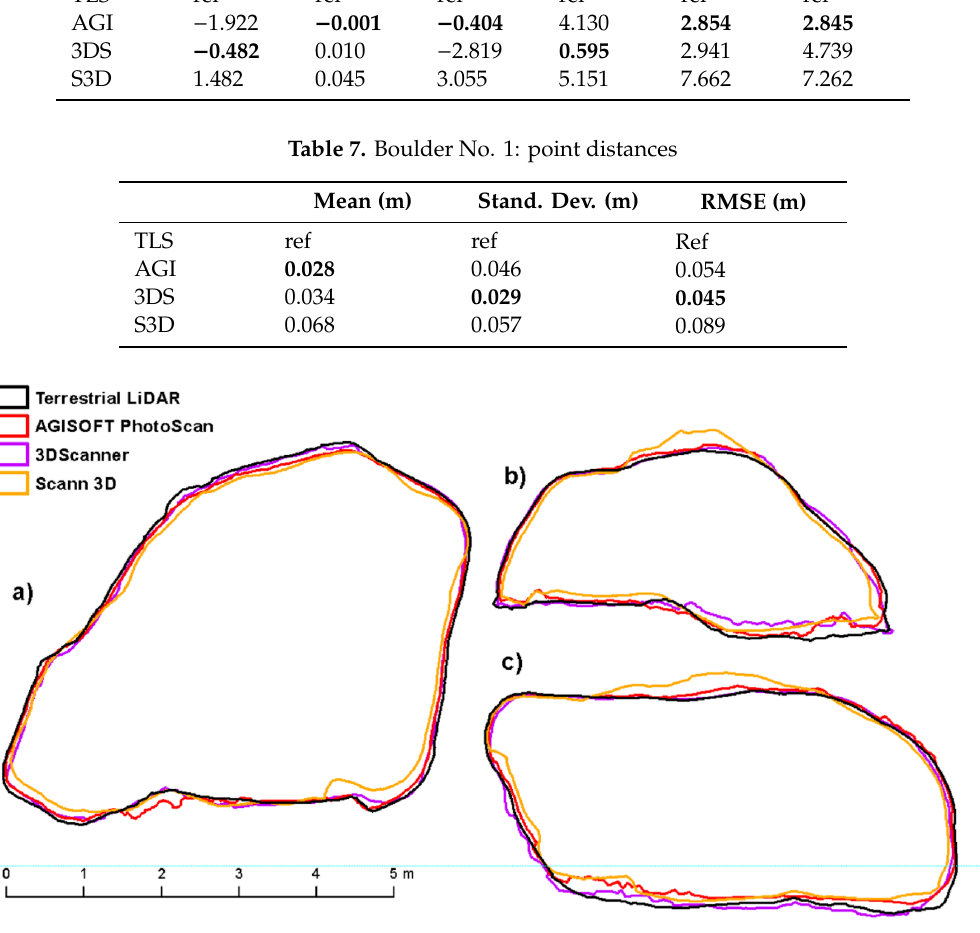
Figure 10. Shapes in cross sections boulder No. 1 (a-X axis, b-Y axis, c-Z axis).